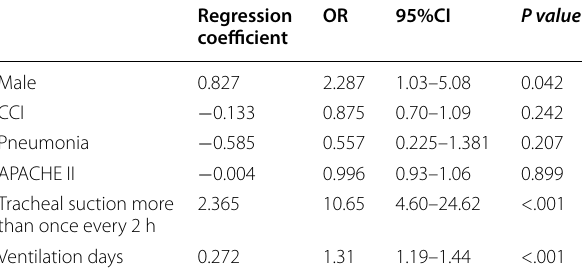
Table 3 Odds ratios regarding variables for extubation